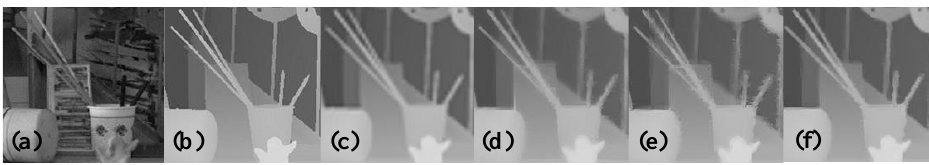
Figure 1. Visual comparison of super-resolved images of the Middlebury Art dataset. ( a ) Original high-res intensity image. ( b ) Original high-res range image. Super-resolved image by ( c ) Bicubic, ( d ) Markov random field (MRF), ( e ) joint bilateral filter (JBF) and ( f ) self-guided joint filtering